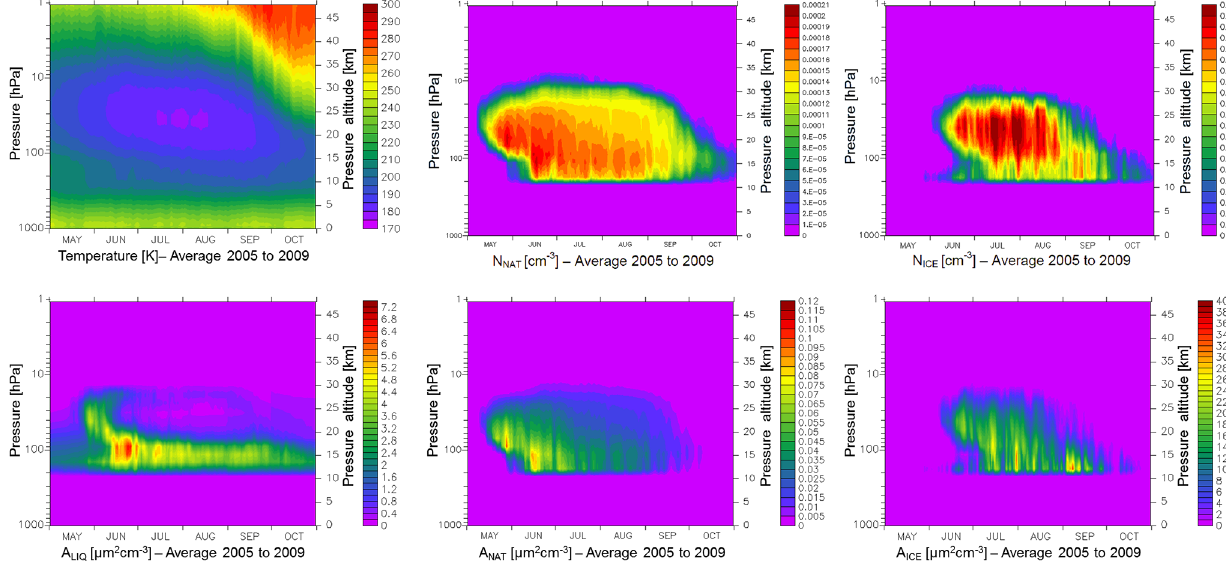
Figure 2. Stratospheric temperature, liquid and solid particles – time series averaged from 80 ◦ to 90 ◦ S and over the years 2005 to 2009 for temperature in K (top left), number densities of NAT ( N NAT ) and ice particles ( N ice ) in cm − 3 (top centre and right), as well as surface area densities of liquid particles ( A liq ), NAT ( A NAT ) and ice particles ( A ice ) in µm 2 cm − 3 (bottom left to right). The results shown are valid for the standard and for all three sensitivity